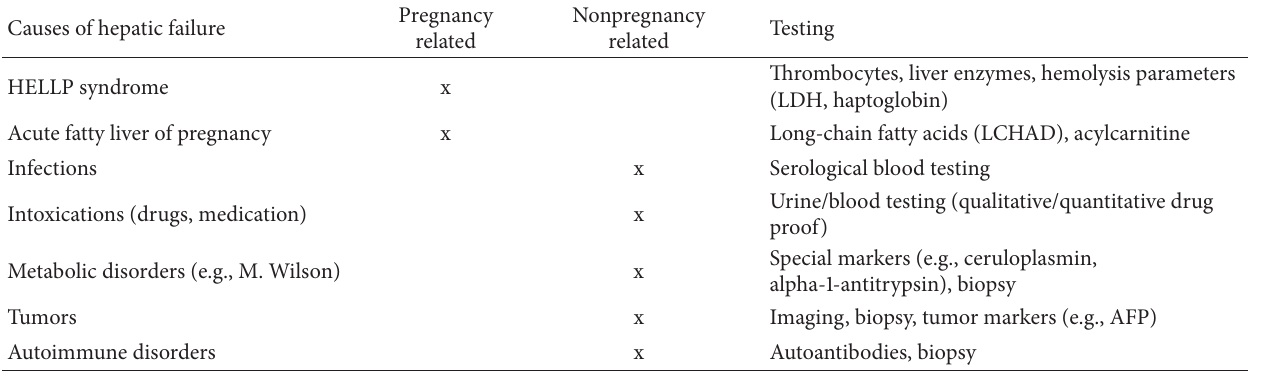
Table 2: Causes of acute hepatic failure during